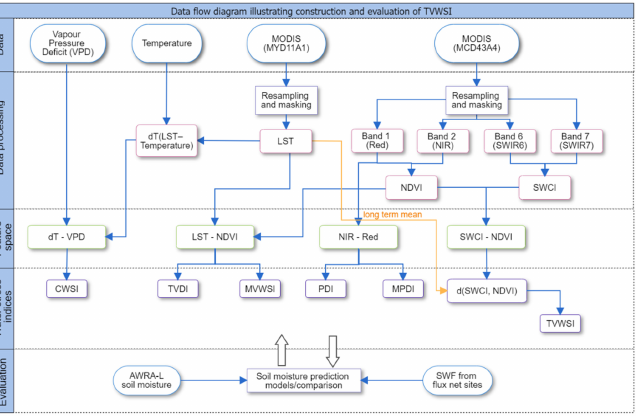
Figure 5. Flowchart illustrating the sequence of data analyses steps for the construction of TWSI and its comparison to existing waters tress indices in predicting AWRA-L soil moisture and Soil Water Fraction from four FLUXNET sites.